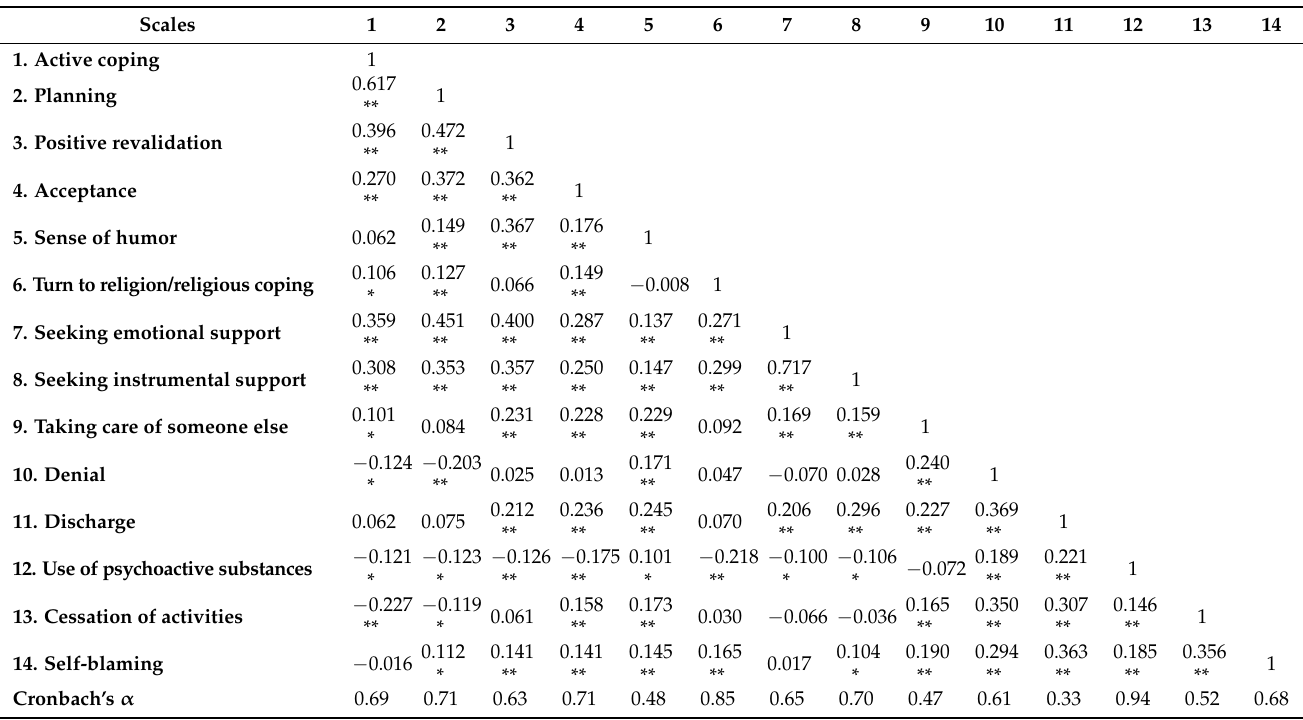
Table 3. Intercorrelations and Cronbach’s α for the scales in the Coping Inventory (MINI-COPE) calculated for a group of seniors ( n =